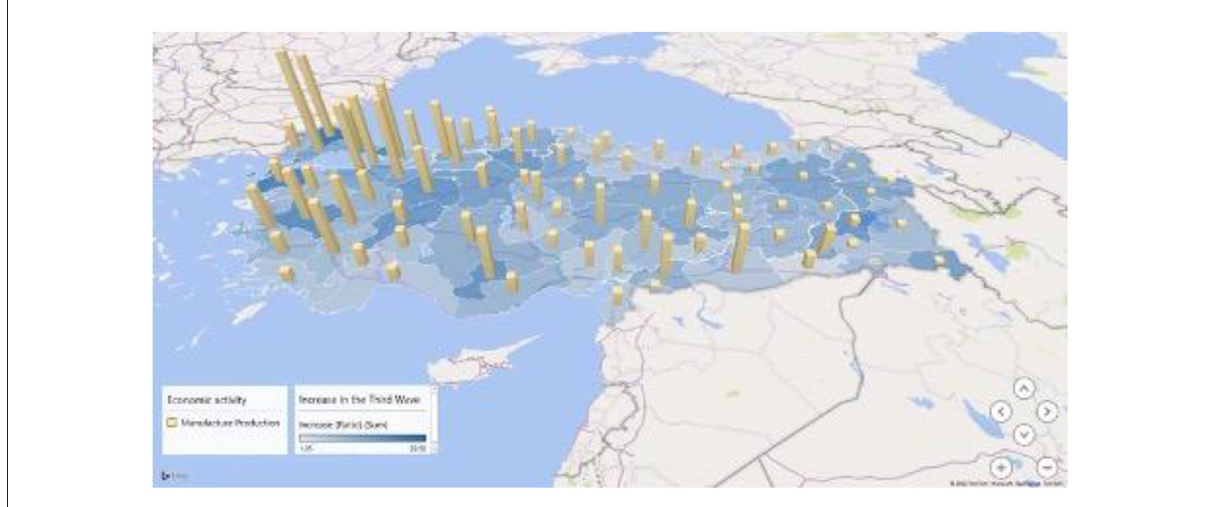
FIGURE5 Attack rate increase ratio and manufacturing industrial activity in the third wave of COVID-19 outbreak in